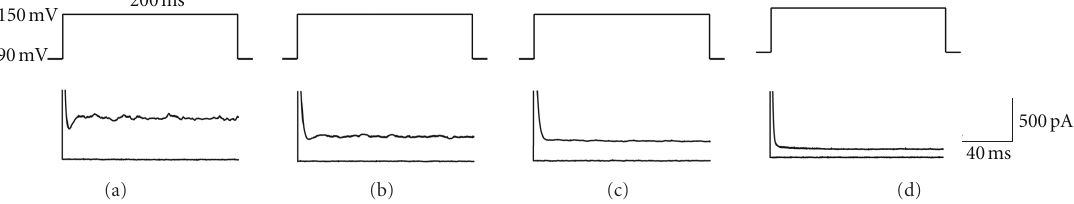
Figure 3: Representative whole cell patch clamp recordings showing outward currents elicited at 150 mV with holding for 200 ms. Bovine articular chondrocytes were treated with PBS (a), 0.25% bupivacaine for 5 minutes (b), 0.25% bupivacaine for 10 minutes (c), and cesium (potassium channel blocker)